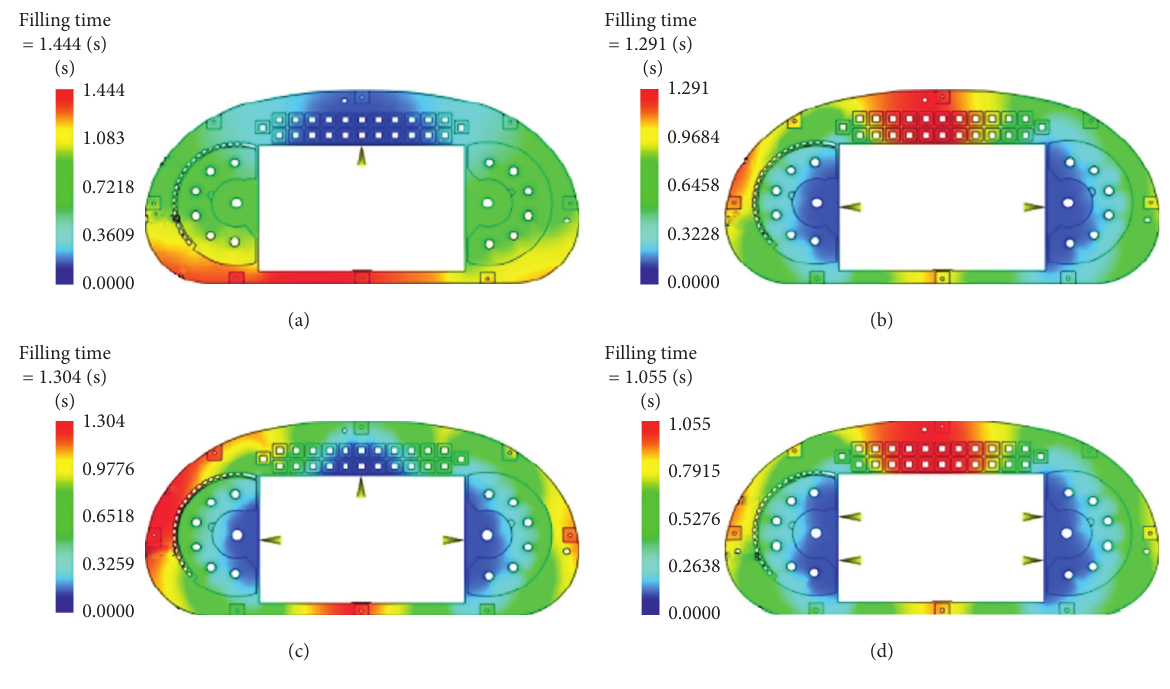
Figure 4: Filling times of the part with different gate